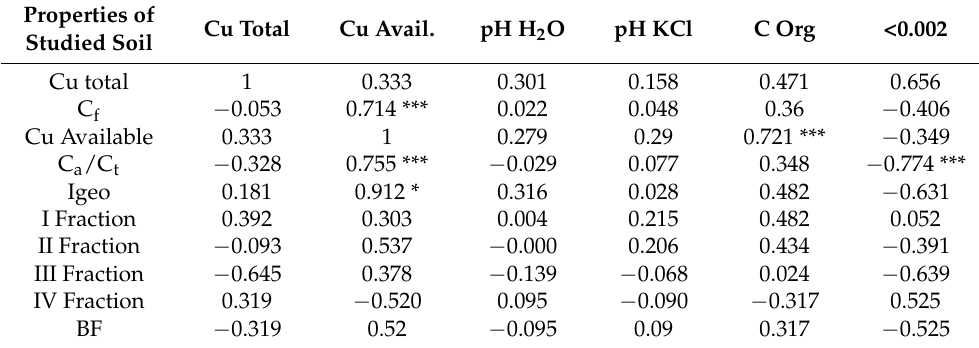
Table 3. Values of Pearson’s correlation coefficients of copper forms and indices with the physico- chemical properties of silty soils.